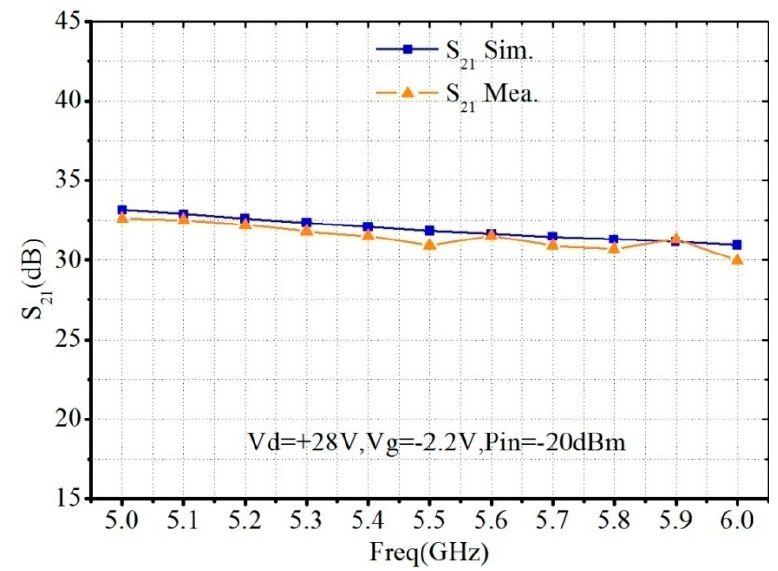
Figure 7. Simulated and measured S 2 1 of the proposed C-band 30 W PA MMIC.